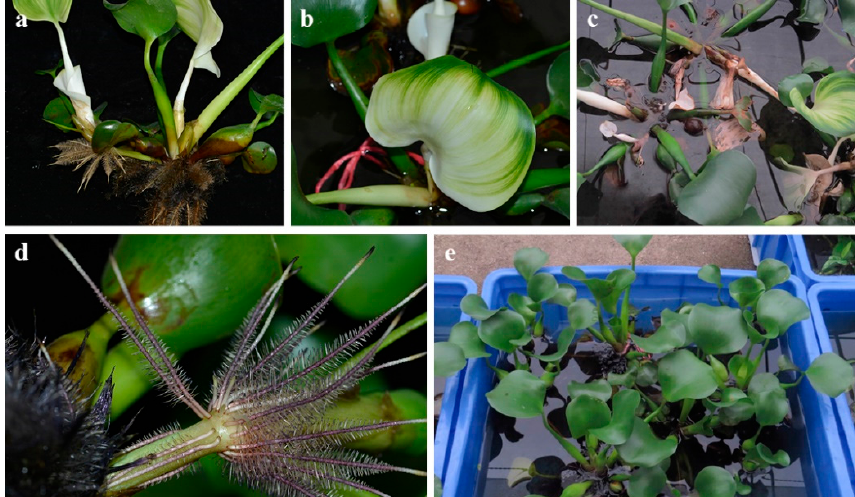
Figure 3. Growth status of Trapa natans in swine manure wastewater: ( a ) day 0 and ( b ) day 15.